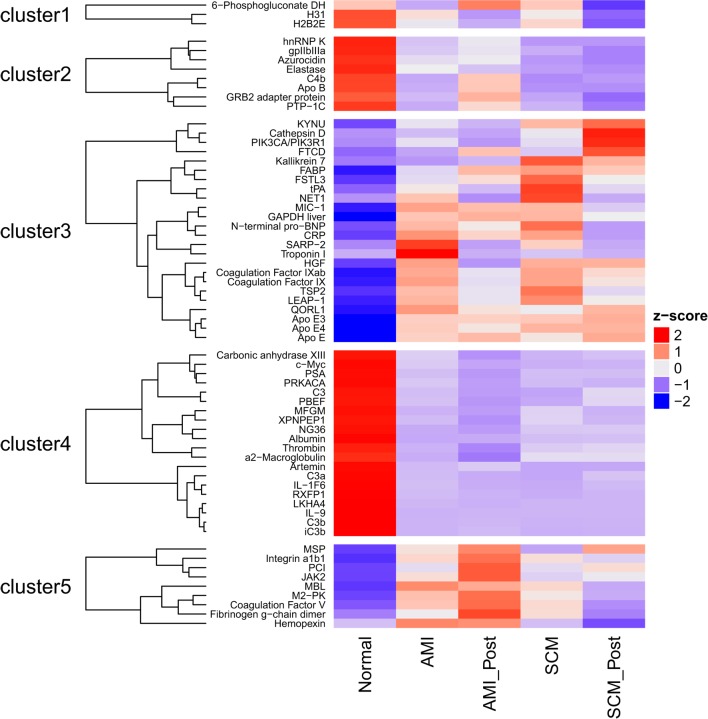
The heatmap shows the serum protein expression in the five groups [normal, the acute myocardial infarction conditions (AMI, AMI_Post) and the stress cardiomyopathy conditions (SCM, SCM_Post)]. By determining if a protein was differentially expressed in one or more of the ten possible comparisons, a list of 64 proteins was generated. Differentially regulated proteins were defined using the following filters (absolute log2 fold change >1; q < 0.05). The average level of each protein, in each of these conditions, was used to generate the heat-map. Bright red is increased expression, and deep purple is decreased expression (Z-score). For example, concentrations of N-terminal pro-BNP (cluster 3) are increased in AMI and SCM compared to normal.